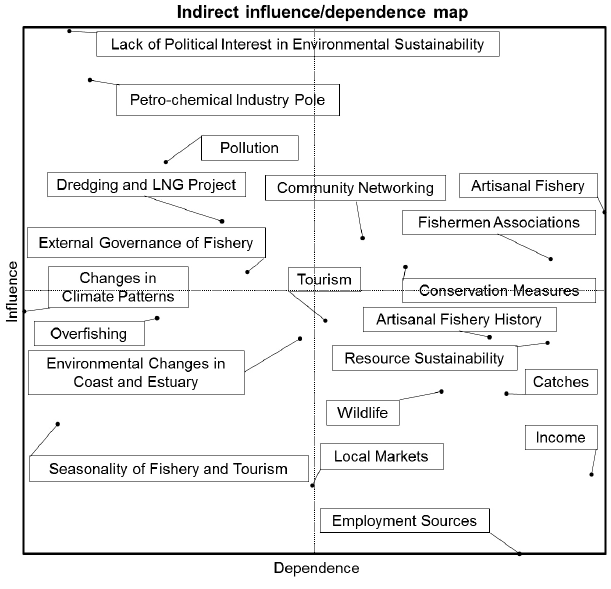
Fig. 8 . Influence/dependence map for indirect influences in Colombia.